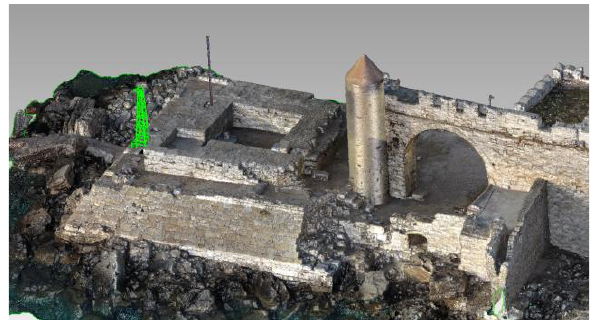
Figure 9: The light 3D Model of the Naillac Pier.